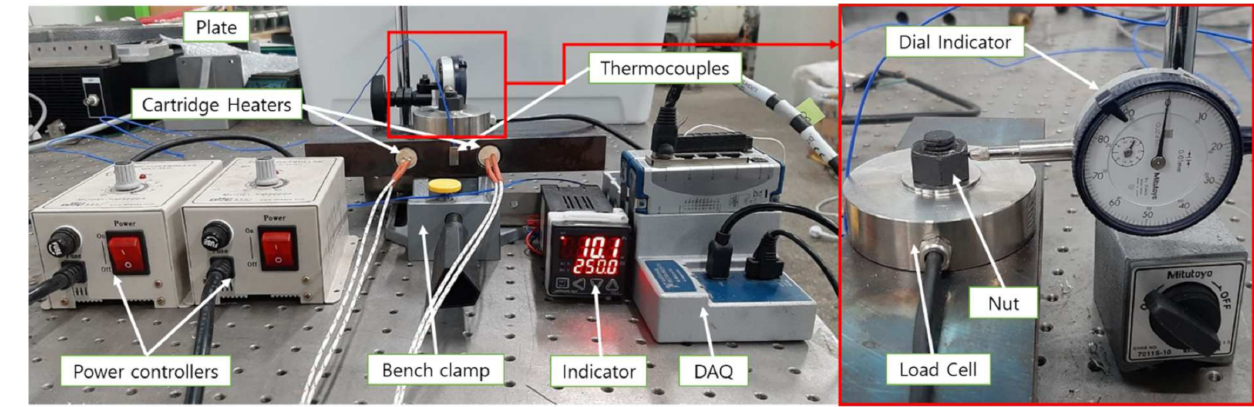
Figure 3. Experimental set